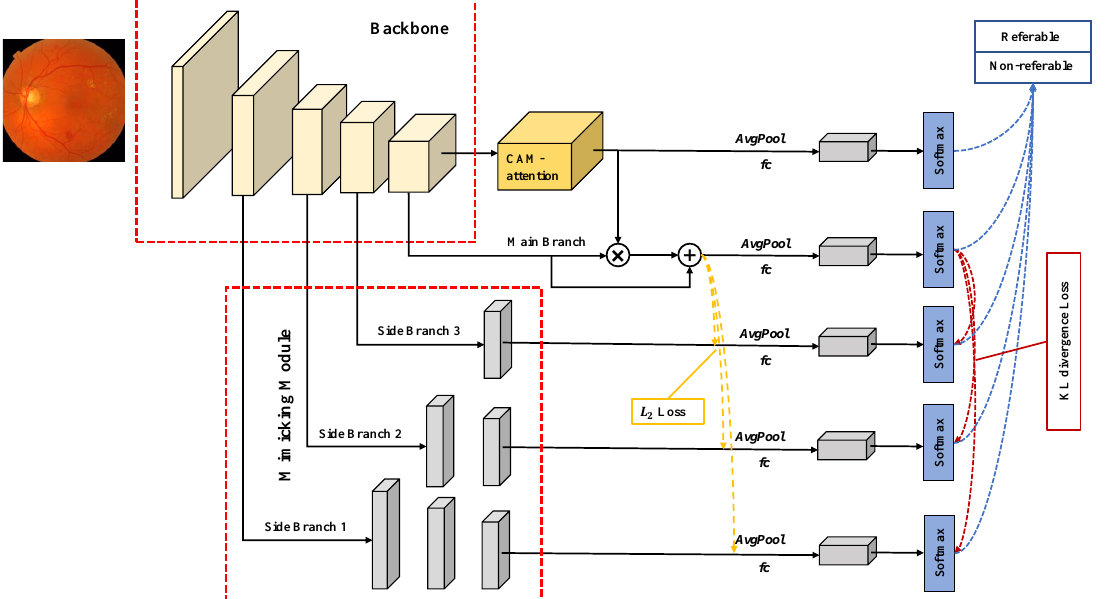
Figure 2. A detailed illustration of our proposed network. In addition to the main branch and the auxiliary attention branch, the proposed framework also has three Side branches attached. Among them, the red dotted box contains multiple groups of ResBlocks ; AvgPool denotes the global average pooling layer; fc denotes the fully connected layer. For binary classification, the images of stage 0 and stage 1 in the Messidor dataset are combined as referable images, and the rest are non-referable images. Backbone and the Mimicking Module will be discussed in Sections 2.3 and 3.2, respectively. Best viewed in